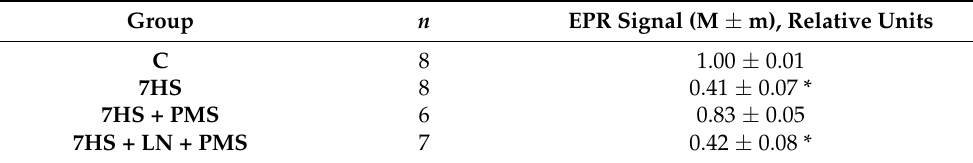
Table 1. Relative NO content in rat soleus muscle in the control group (C), 7-day hindlimb-suspended group (7HS), 7-day hindlimb suspended group with plantar mechanical stimulation (7HS + PMS), 7-day hindlimb suspended group with plantar mechanical stimulation+ L-NAME introduction (7HS + LN + PMS). *—significant difference from control group ( p < 0.05). Group n EPR Signal (M ± m), Relative Units C 8 1.00 ± 0.01 7HS 8 0.41 ± 0.07 * 7HS + PMS 6 0.83 ± 0.05 7HS + LN + PMS 7 0.42 ± 0.08 *